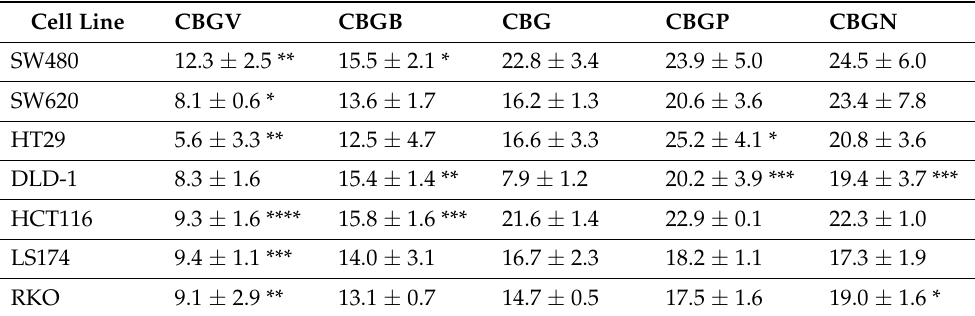
Table 1. IC 50 values for CBG variants in Colorectal Cancer Cell Lines.